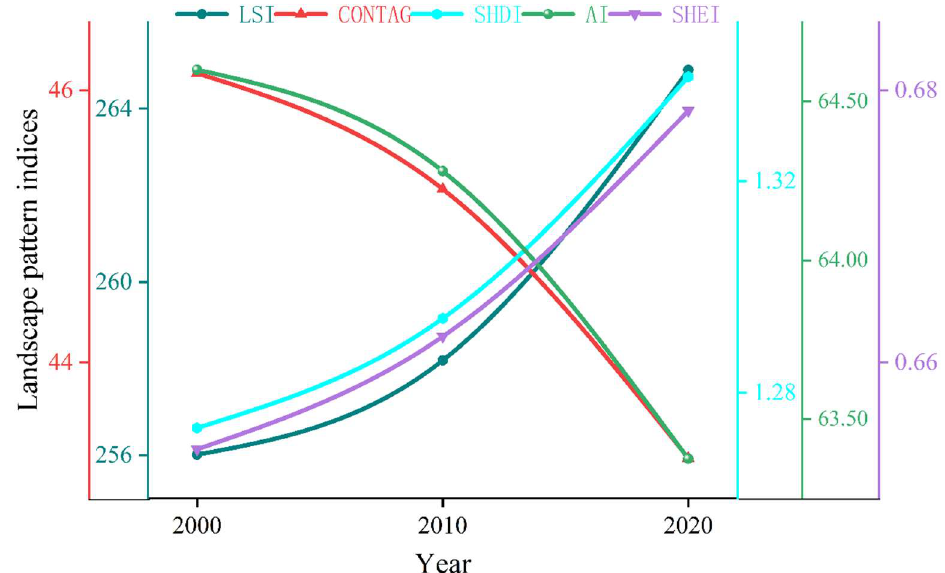
Figure 13. Changes in landscape pattern indices at the landscape level in the Yangtze River Economic Belt from 2000 to 2020.